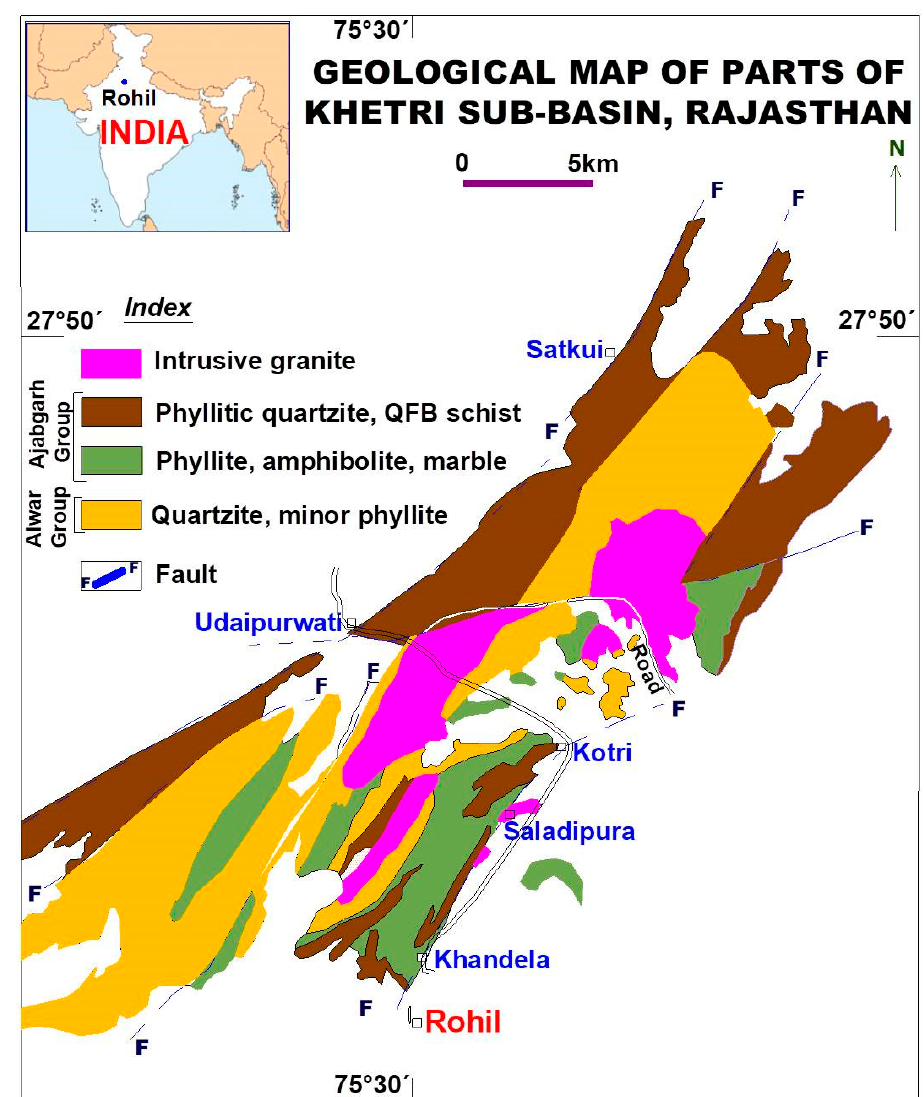
Figure 2. Geological map of part of the Khetri sub-basin of the North Delhi Fold Belt and the location of Rohil (modified after [22]).